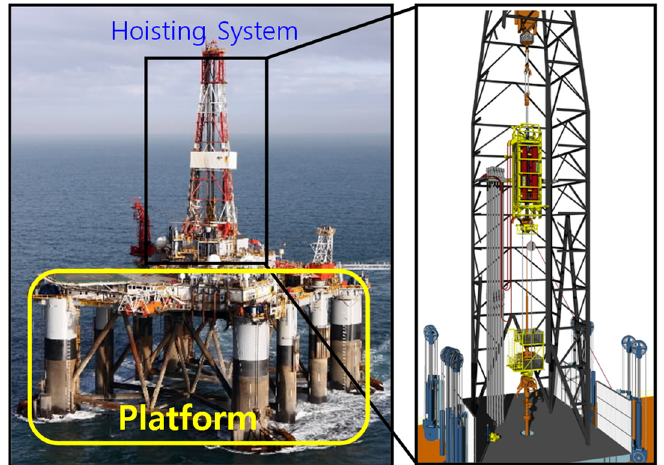
Figure 1. Various types of mechanical systems in the shipbuilding industry; ( a ) goliath crane; ( b ) floating crane; and ( c ) offshore drilling rig.